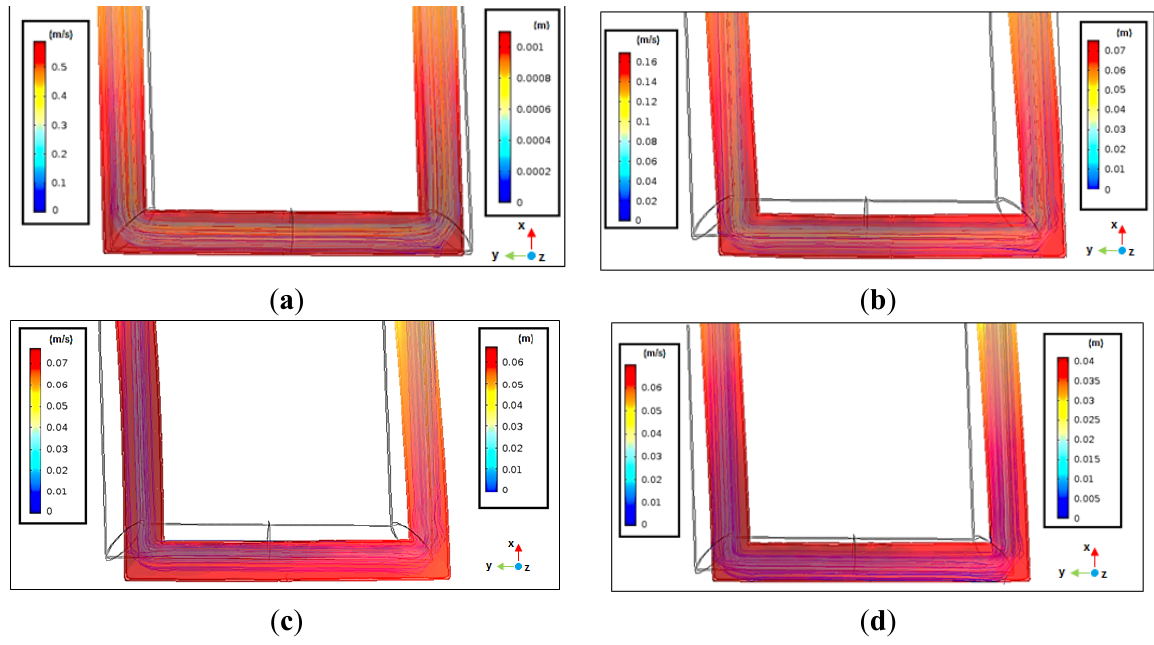
Figure 21. Fluid velocity (streamlines) and pipe displacement (contours) fields during the first wave period: ( a ) t = 0.50 s; ( b ) t = 0.55 s; ( c ) t = 0.60 s; and ( d ) t = 0.96